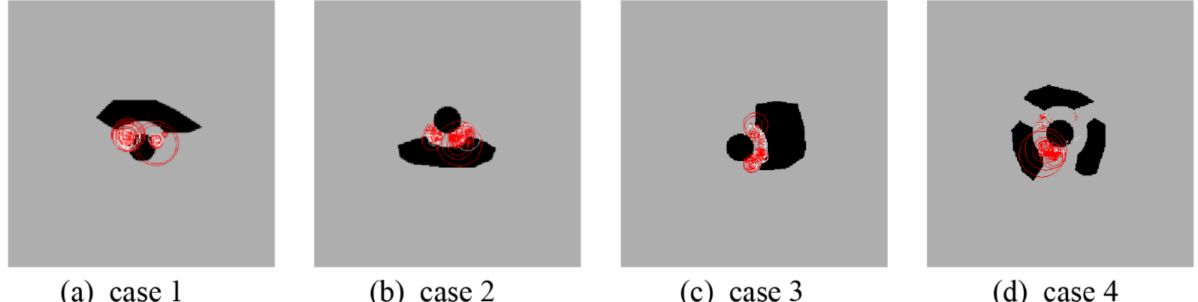
Figure 5. Numerical calculation results of damage characteristics of grouting for different relative positions of the tunnel and the cave: ( a ) tunnel under the cave; ( b ) tunnel up through the cave; ( c ) tunnel side crossing the cave; ( d ) tunnel through the cave cluster.